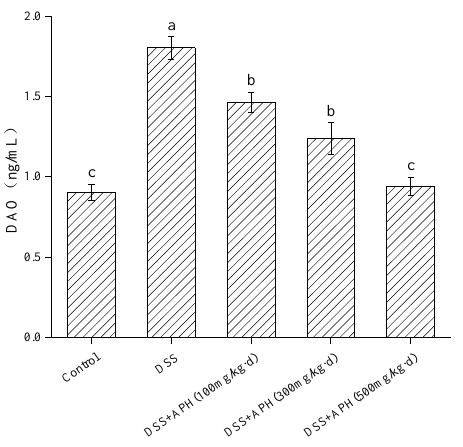
Figure 5. Effects of APH on DAO level in serum of DSS-induced colitis mice. Data are expressed as mean ± SD ( n = 8). Different letters indicate significant differences ( p < 0.05).